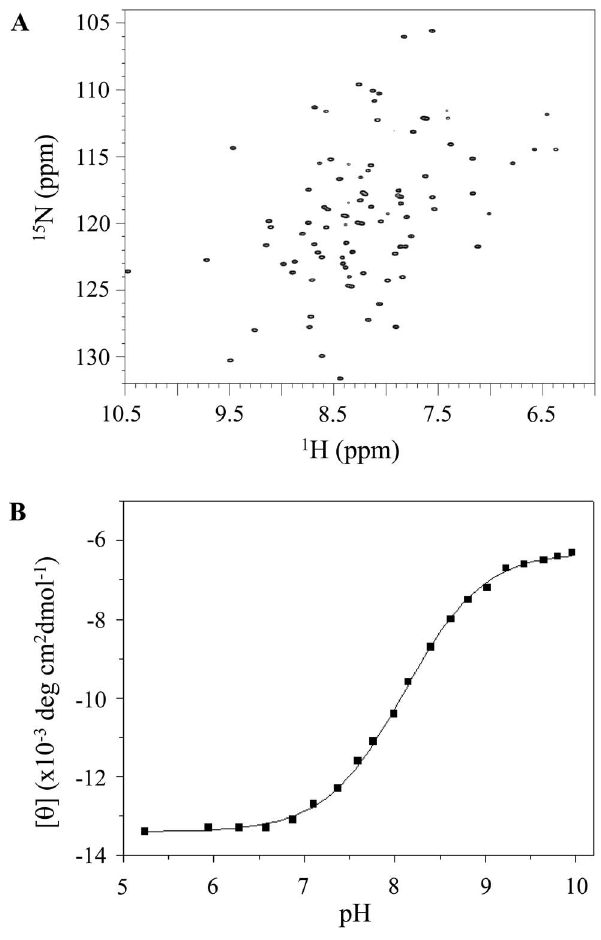
Figure 6. 1 H- 15 N HSQC spectra and the change in the CD signal intensity at 218 nm over a pH range of 5.2-10.0. ( A ) 1 H- 15 N HSQC spectra for the ESD (E83L/E105) mutant in 10 mM HEPES, pH 7.5 and 10 mM sodium acetate, pH 4.5 containing 100 mM NaCl. ( B ) The pKa value was determined by fitting the data using the Henderson- Hasselbach equation (solid